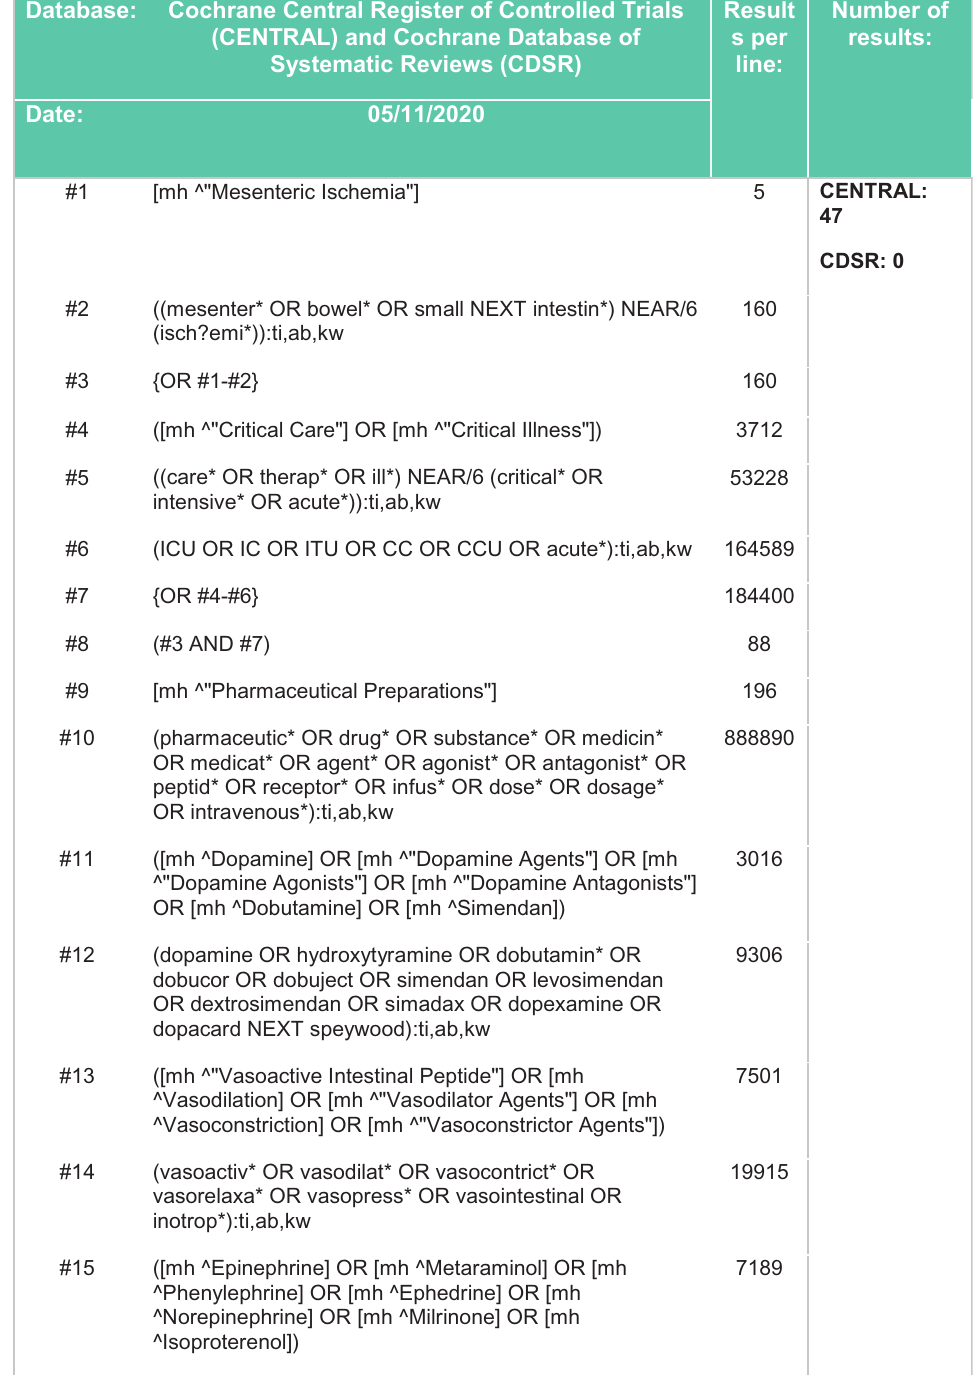
Figure 4. Search strategy - Cochrane Central Register of Controlled Trials (CENTRAL), Cochrane Database of Systematic Reviews (CDSR).